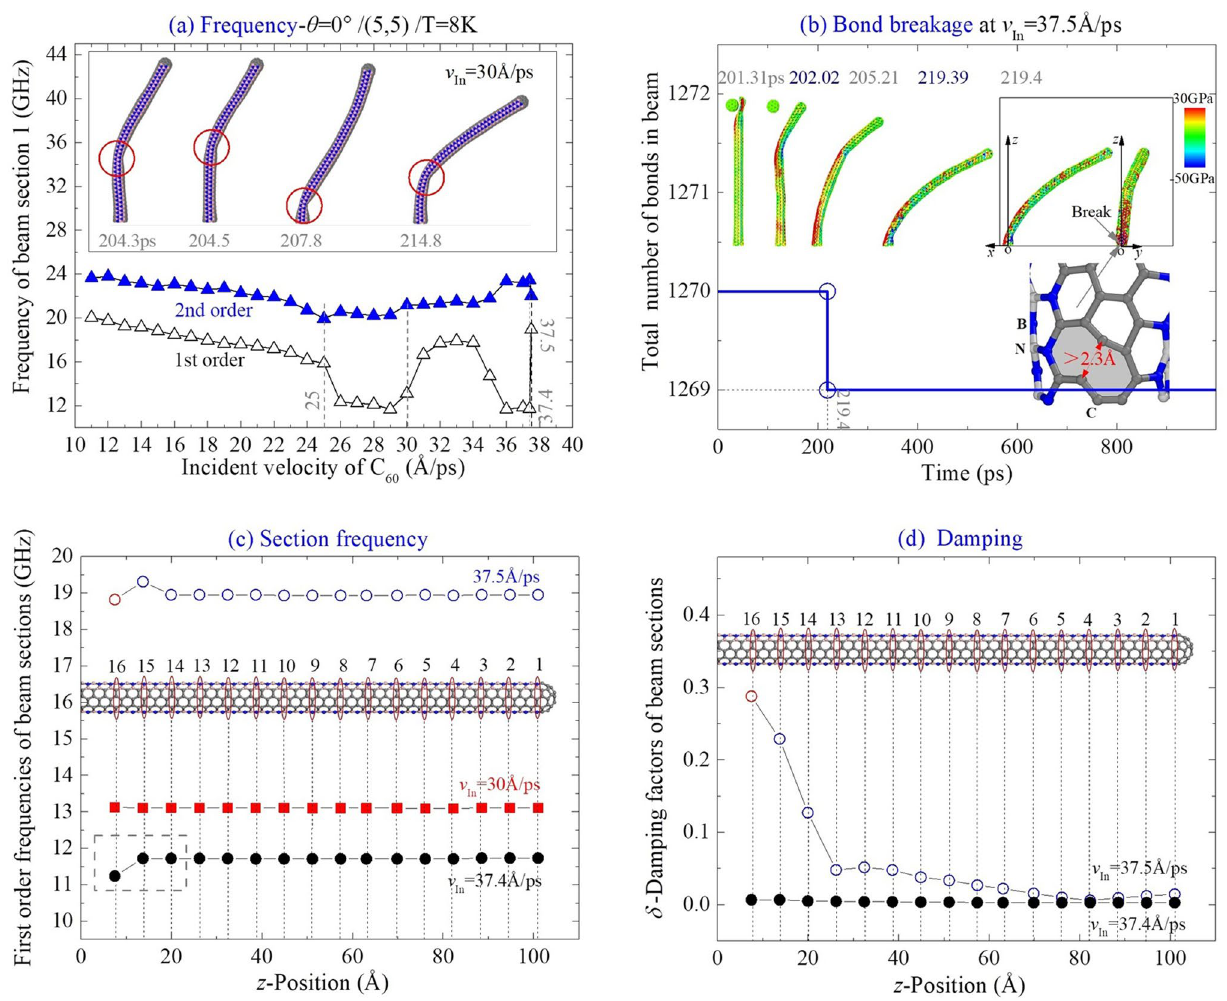
Figure 6. Vibration analysis of (5, 5) the nanobeam impacted by a high-speed C 60 along the path of θ = 0° at 8 K. ( a ) Natural frequencies of the beam impacted by the C 60 with different incident velocities. Snapshots of buckled beam are inserted. ( b ) At MIV_D = 37.5 /ps, beam has a breakage of bond C–C in the zone I near the fixed end. ( c ) Comparison of frequencies of beam sections with respect to different incident velocities. ( d ) Å Damping factors of beam